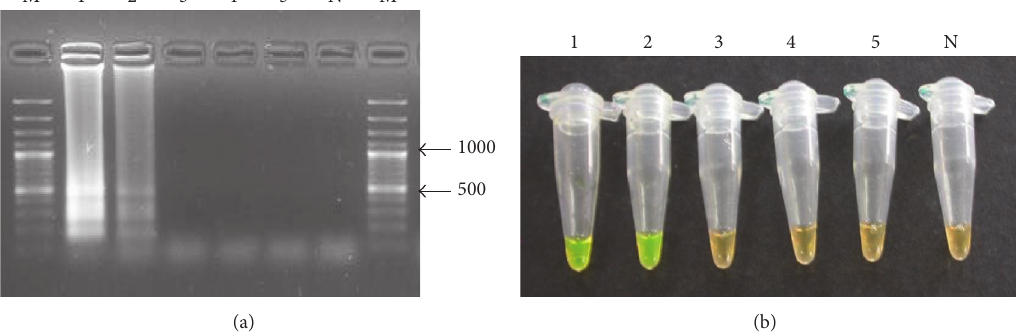
Figure 3: (a) Specificity of LAMP assay by gel electrophoresis. Lane 1, A. lumbricoides adult worm; lane 2, Ascaris ova DNA; lane 3, hookworm ova DNA; lane 4, S. mansoni ova DNA; lane 5, T. trichiura ova DNA; lane N, negative control; and M = 100bp molecular ruler (Thermo Scientific). (b) Visual detection by color change using the SYBR Green dye. Tube 1, A. lumbricoides adult worm; tube 2, Ascaris ova DNA; tube 3, hookworm ova DNA; tube 4, S. mansoni ova DNA; tube 5, T. trichiura ova DNA; and lane N, negative